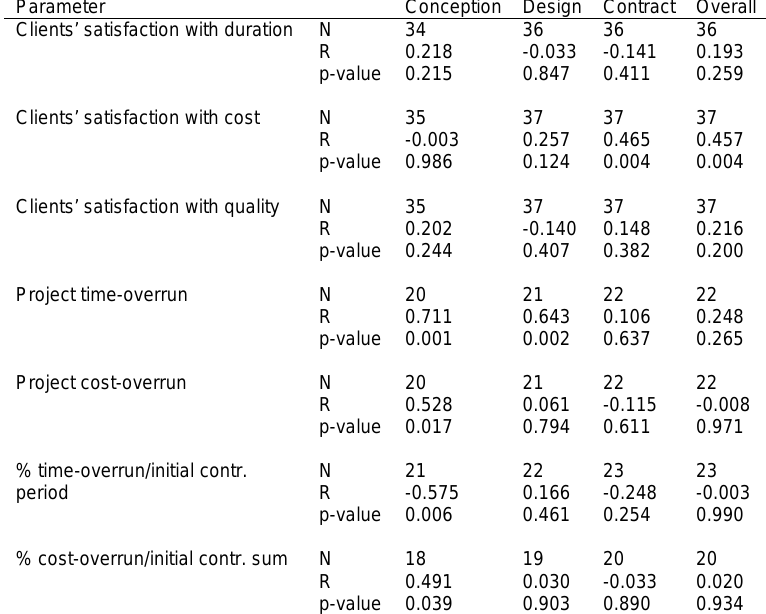
Table 7: Results of the Spearman test of correlation between the level of project planning and performance of projects procured by private